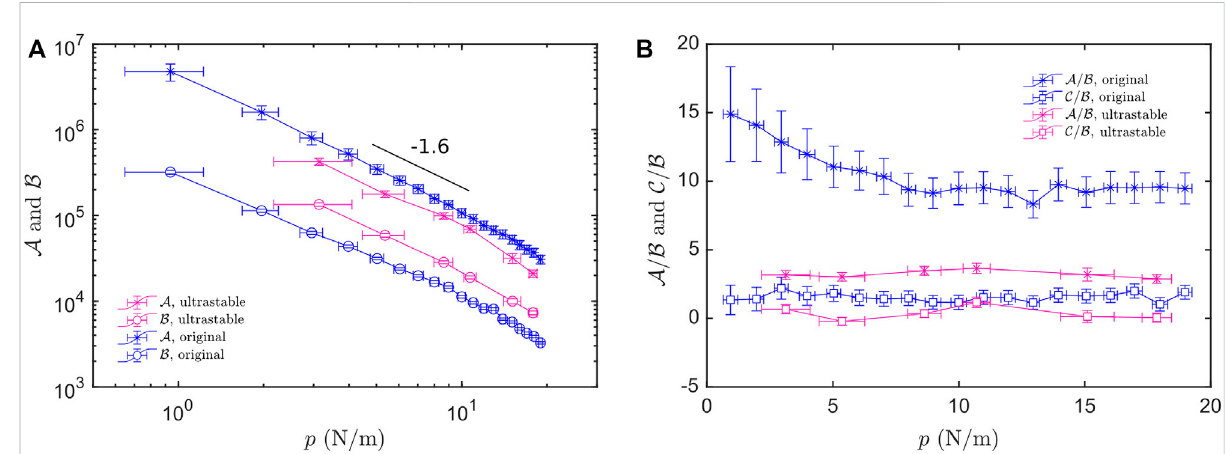
FIGURE 10 The VCTG fi t results for the ultrastable states and the original states. A , B , and C are de fi ned in Eq. 17 (A) The VCTG fi t results A and B plotted versus pressurefororiginalandultrastable states.Notethat aninterpretationis E x ′ (cid:2) 1/ A and E y ′ (cid:2) 1/ B where E x ’ and E y ’ aretheYoung ’ smoduli ofthe anisotropic system along the principal dilation and compression directions of the initial shear respectively. (B) The ratios of the VCTG fi t results A / B and C / B plotted versus pressurefororiginalandultrastablestates.Theratio A / B isclearlymuchlargerfororiginalstates,constitutingafeatureto distinguish these two types of